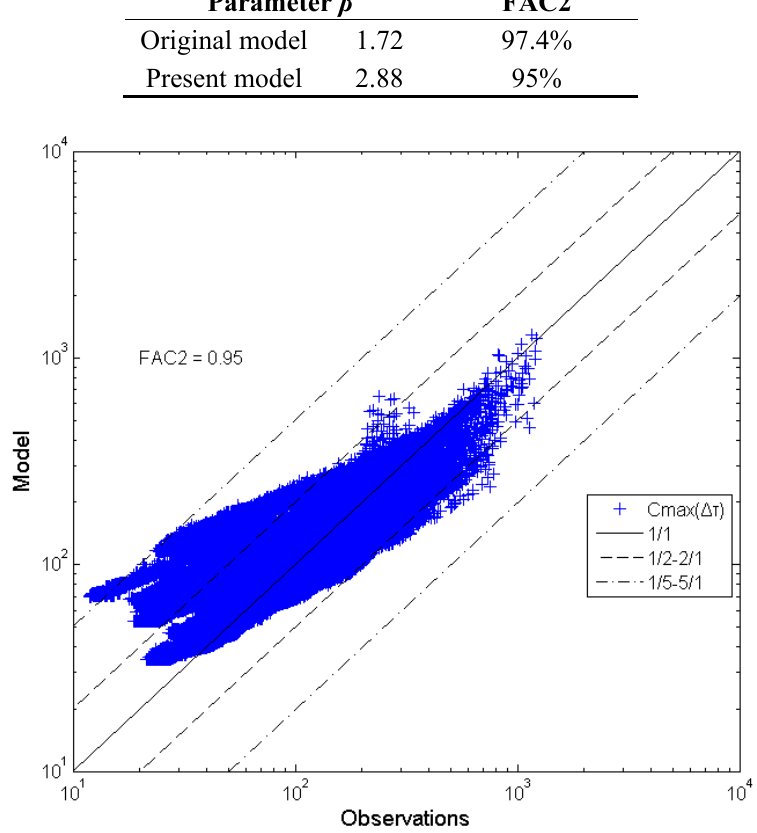
Figure 4. Peak concentration comparisons ( Δτ / Δτ 0 =